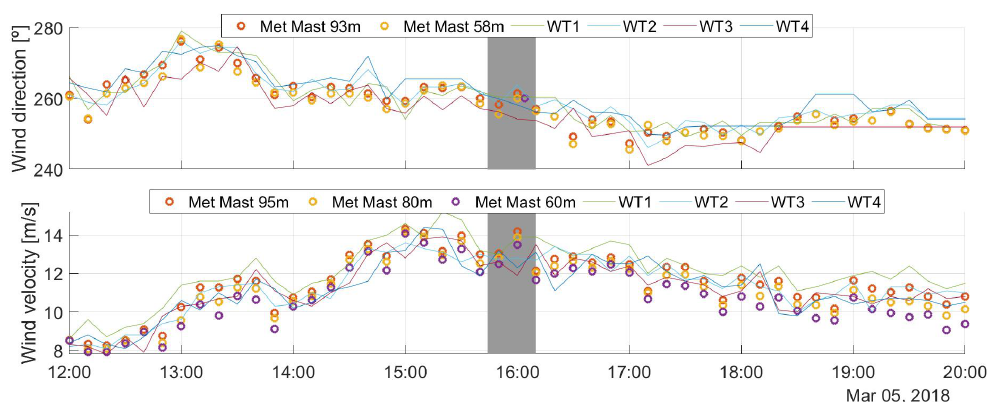
Figure 4. Wind direction (top) and wind velocity (bottom) ten minute averages, acquired by the meteorological mast and the four wind turbines on 5 March, 2018. The grey area indicates the simulated period when the numerical results are compared with 1 Hz of SCADA data (not shown in this